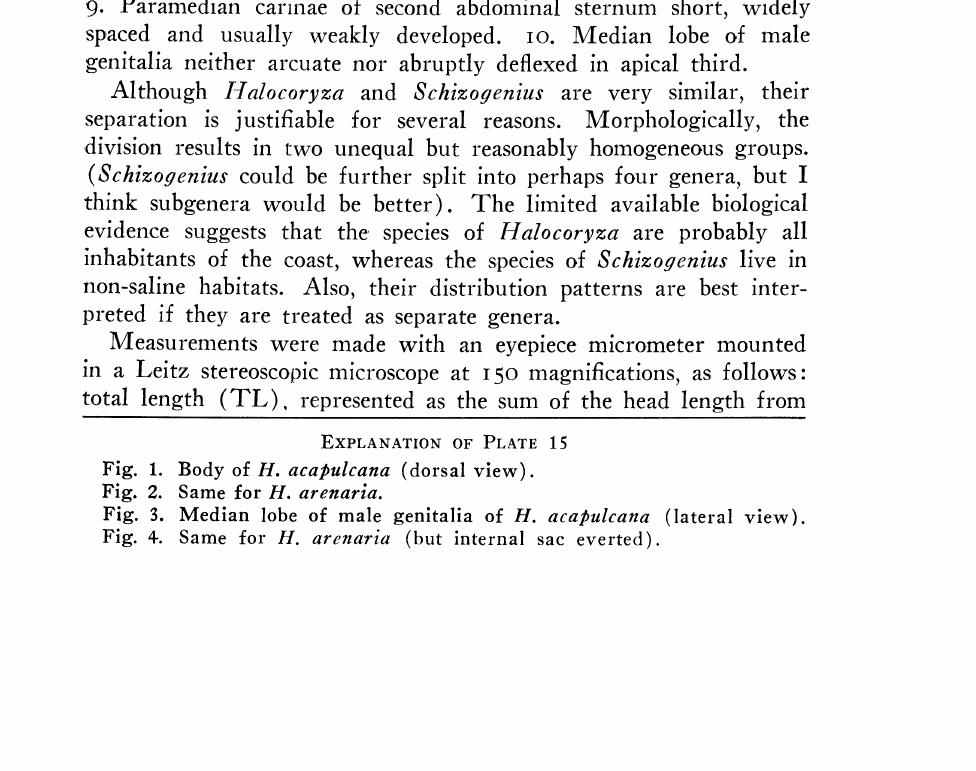
Fig. 1. Body of H. acapulcana (dorsal view). Fig. 2. Same for H. arenaria. Fig. 3. Median lobe of male genitalia of H. acapulcana (lateral view). Fig. 4. Same for H. arenaria (but internal sac